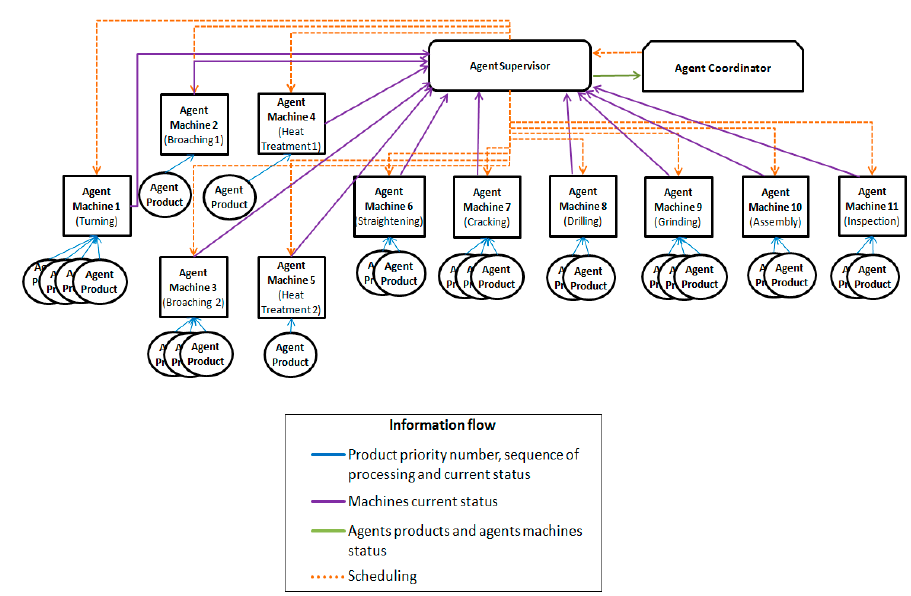
Figure 6. Implementation of the framework for the Case Study analyzed, presented preliminarily in Reference [23].